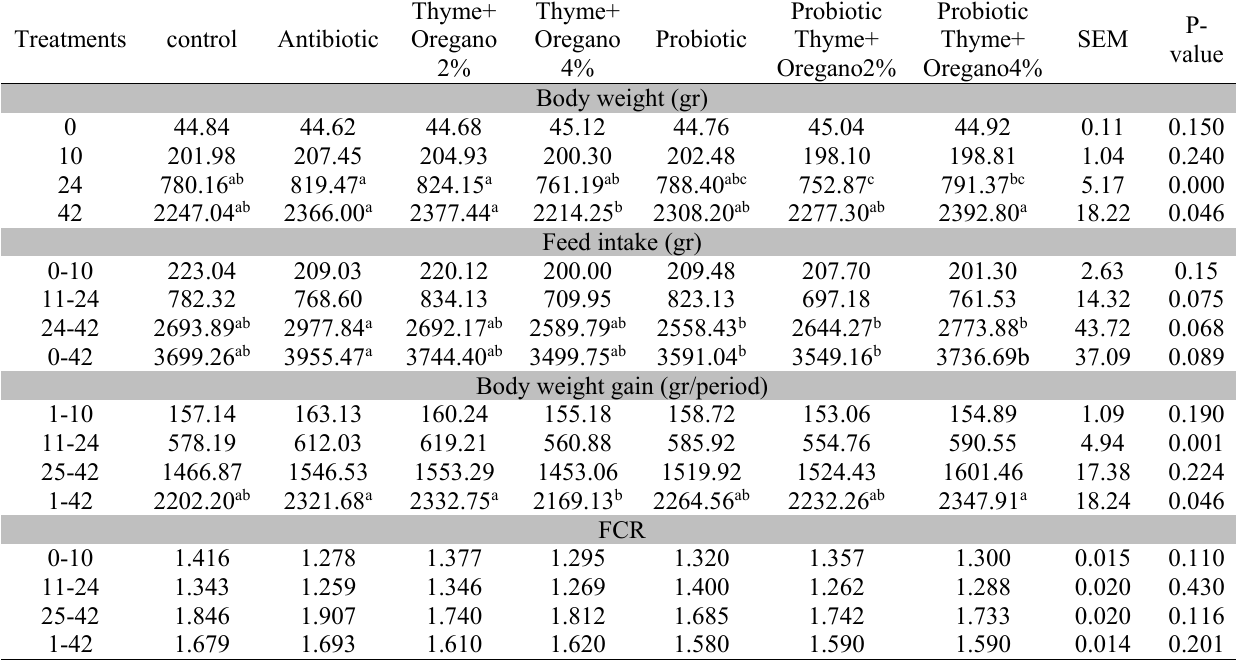
The effects of treatments on growth performance